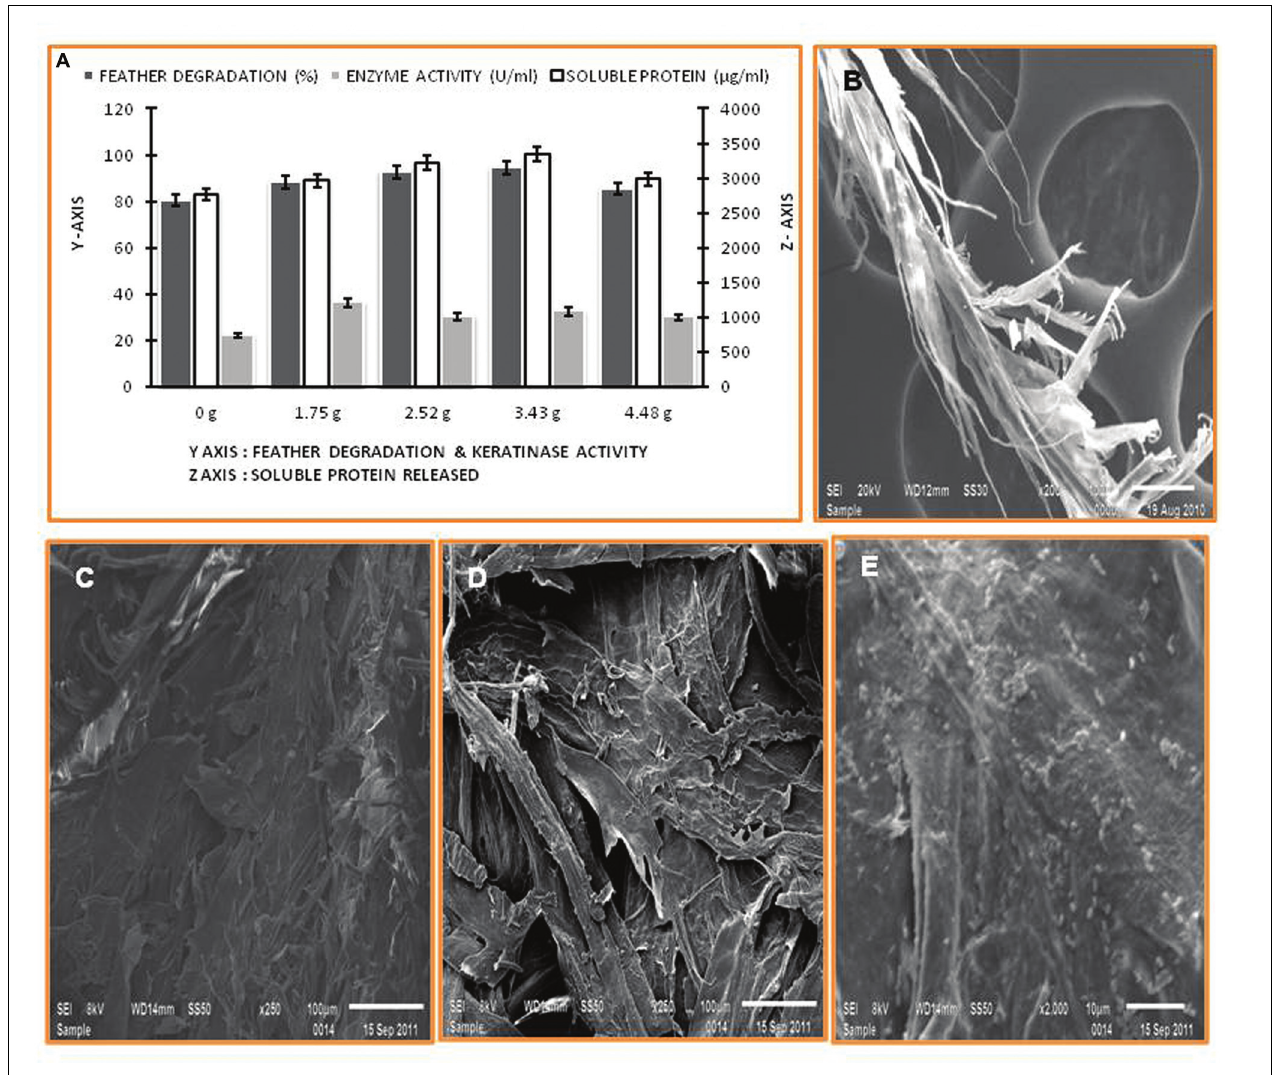
FIGURE 3 | Feather degradation, keratinase activity, and soluble protein released under different rates of agitation, and SEM of degraded feather. (A) Effect of agitation rate; (B–E) SEM of feather degradation in keratinase production media.